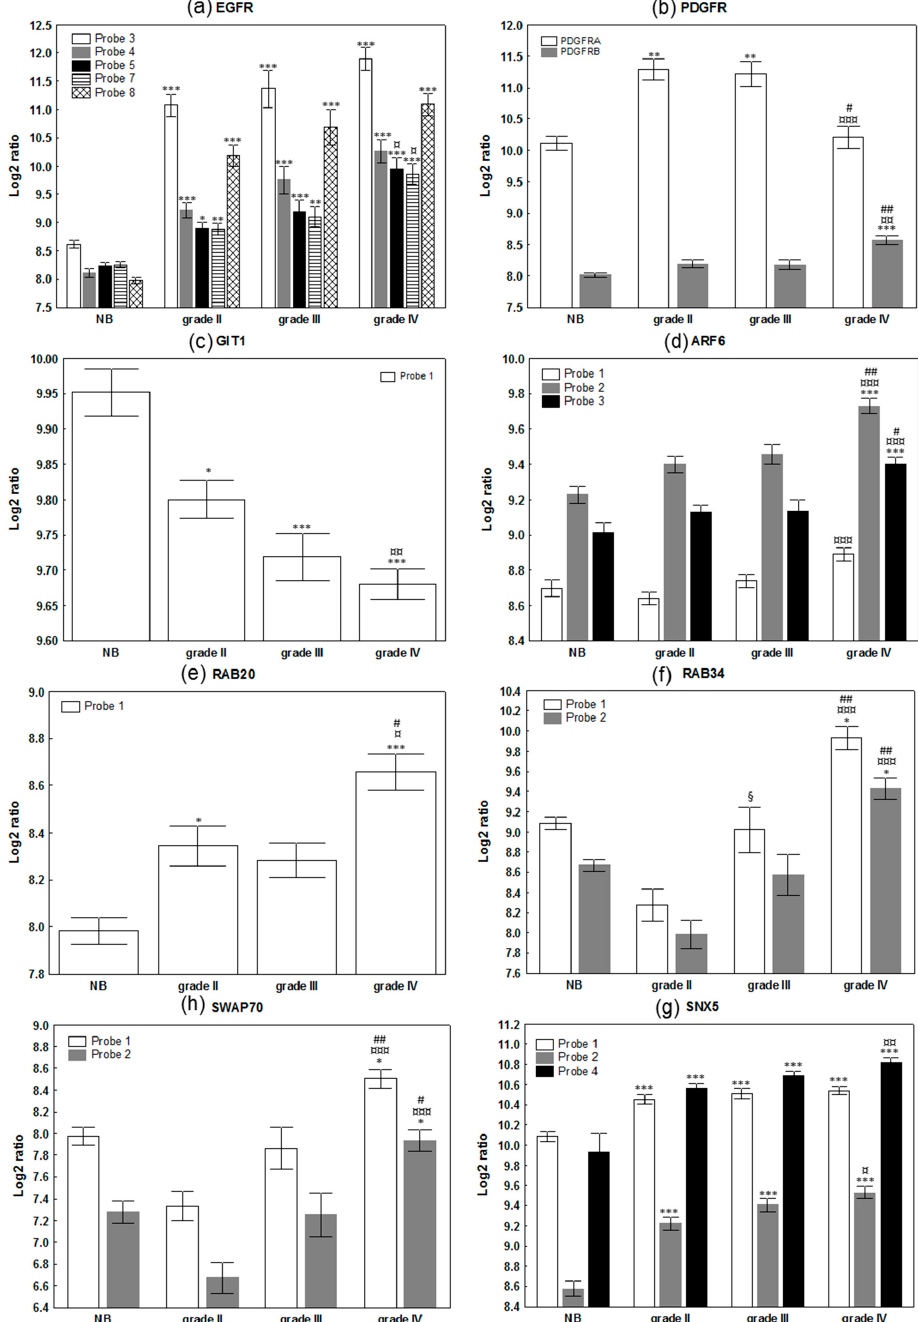
Figure 1. mRNA expression level of selected targets involved in macropinocytosis in patient brain samples. Data are expressed as mean ± SEM of mRNA intensities of each probe expressed in log 2 ratio. NB: normal brain; grade II, III and IV: glioma samples according to the histopathological grade of the tumor. ( a ) epidermal growth factor receptor ( EGFR ), ( b ) platelet-derived growth factor receptor A ( PDGFRA ) and PDGFRB , ( c ) GIT1 , ( d ) ARF6 , ( e ) RAB20 , ( f ) RAB34 , ( g ) SWAP70 and ( h ) SNX5 . Note that only probes with the highest intensities are presented for clarity of the figure with respect to EGFR and SNX5 . Statistical comparisons with the non-tumoral brain samples are represented by (*), statistical comparisons between grade II and IV by ( ), between grade III and IV by (#) and between grade II and III by (§). All statistics are based on two-tailed tests according to conventional thresholds: p < 0.05 (*, , # or §), p < 0.01 (**, , ## or §§) and p < 0.001 (***, , ### or